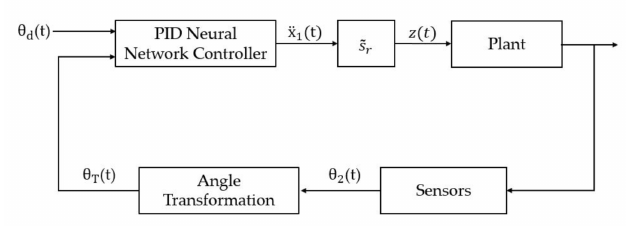
Figure 9. Schematic block diagram of the ankle exoskeleton